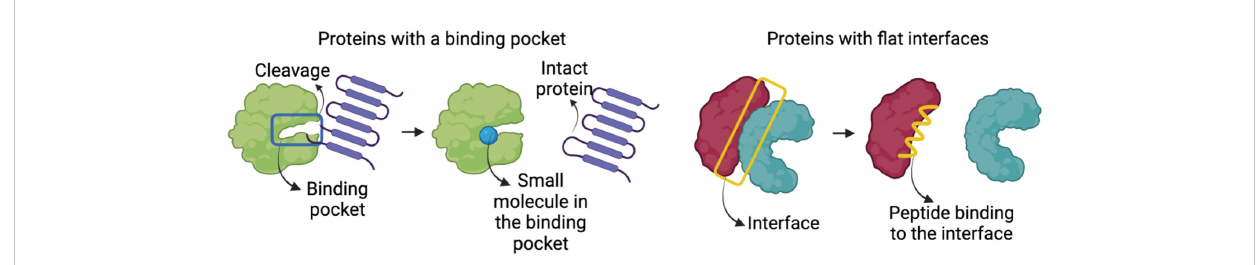
FIGURE 3 Representation of a protein with binding pockets/cavities and proteins with large fl at